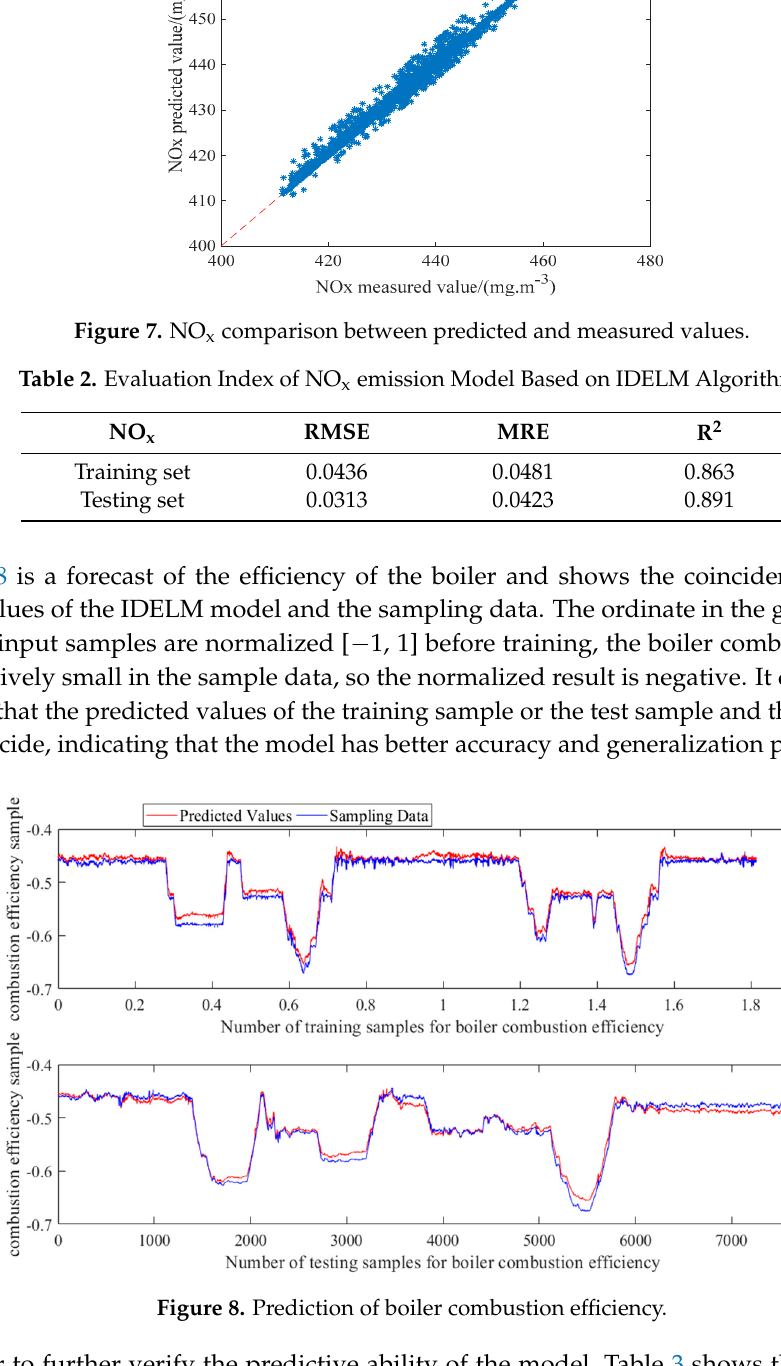
Table 3. Evaluation index of boiler combustion efficiency model based on IDELM algorithm.